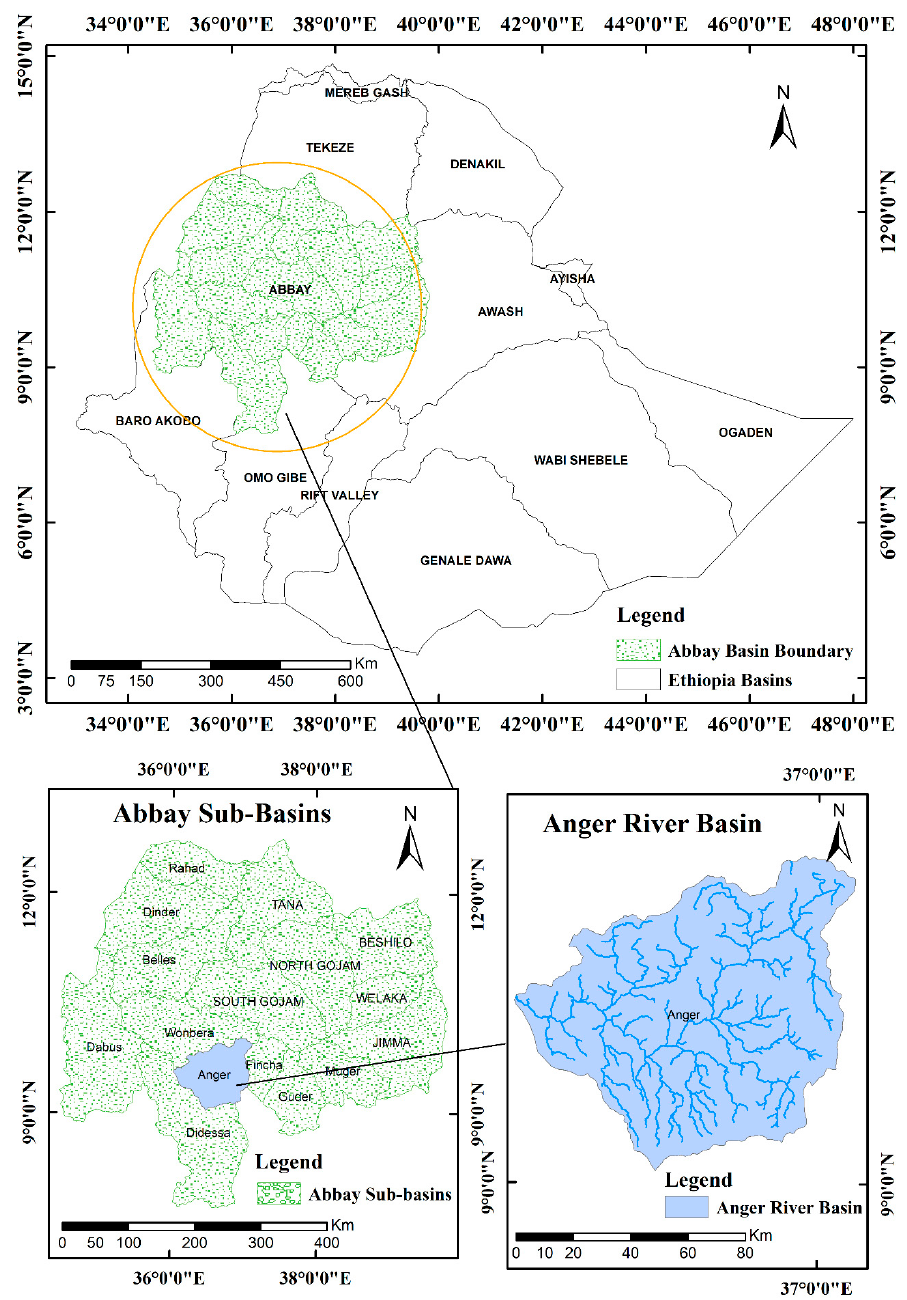
Figure 1. Location of the study area.